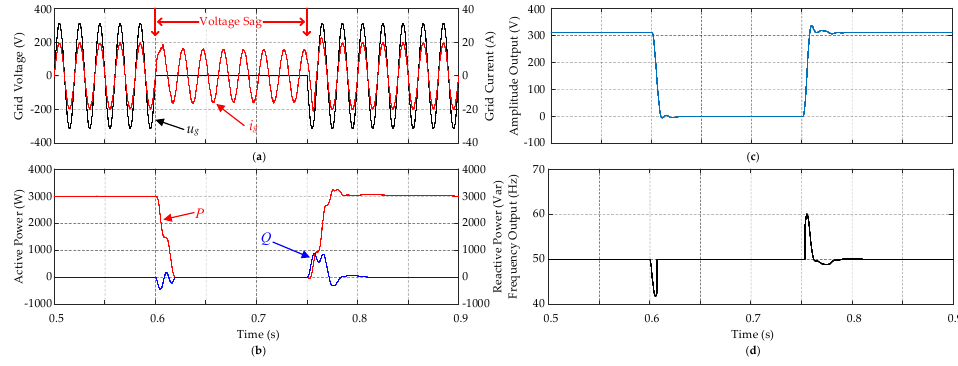
Figure 13. Performance of the PV system with modified PLL-based SOGI-OSG during ZVRT: ( a ) grid voltage and current; ( b ) active and reactive power; ( c ) amplitude estimation; ( d ) frequency estimation.